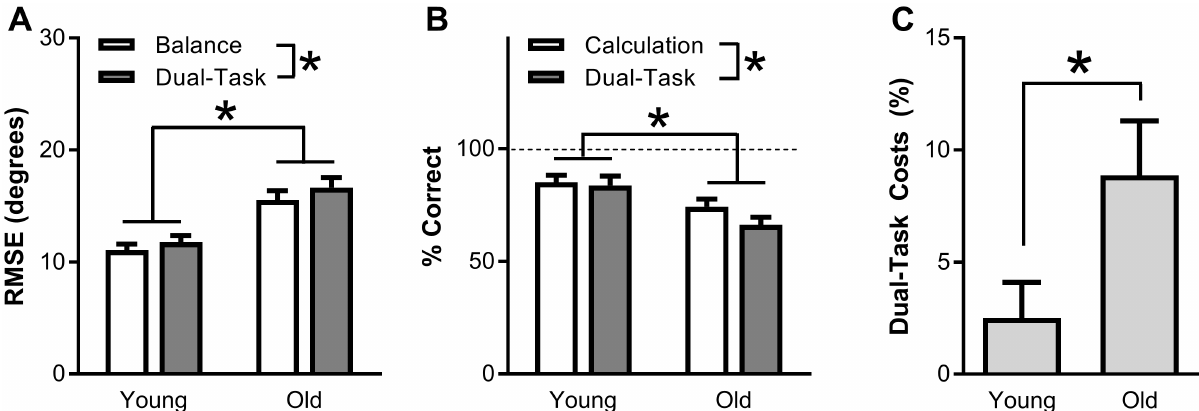
Fig 2. Behavioral group data for young and old adults, showing the root-mean-square error (RMSE) angle between the avatar and the vertical during balance and dual-tasking (A), percentage trials with a correct answer on the calculation task during calculation and dual-tasking (B), and performance decline from single- to dual-tasking, averagedover the balance and calculation tasks (C). Asterisks denote statistical significance (p < 0.05).